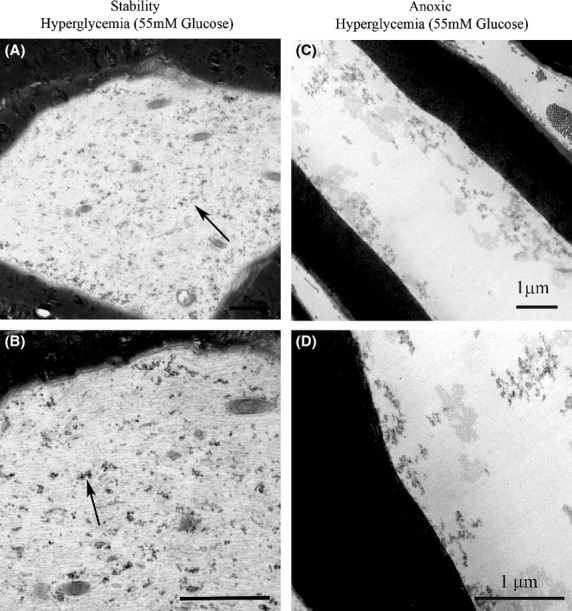
Electron micrographs of axons undergoing anoxia in the presence of 55.5 mmol/L glucose. (A, B) In the fully oxygenated state, axoplasm and cytoskeleton appear well-defined with neurofilaments present but increasing pools of glycogen (arrows) (a = 12,500X, b = 31,500X). (C, D) In the nerves subject to anoxia, degenerating axons are apparent with axoplasm showing severe disruption of the cytoskeleton and loss of neurofilaments (c = 12,500X, d = 31,500X). The contrast in images (C) and (D) was altered after acquisition in order to enhance visualization of the changes in the axoplasm.